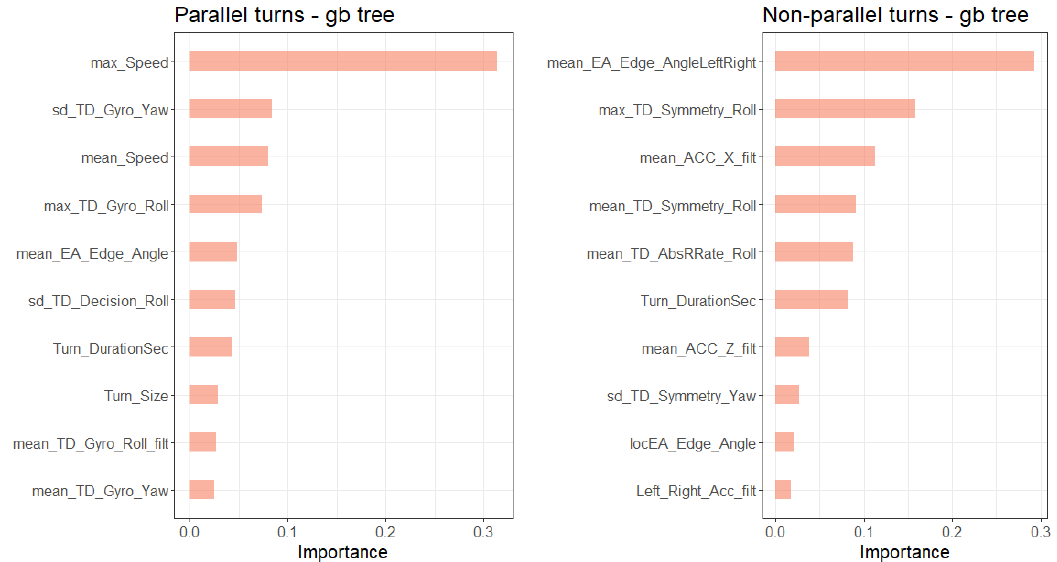
Figure 8. Variable importance plot of the 10 most important variables of the gradient boosted tree .